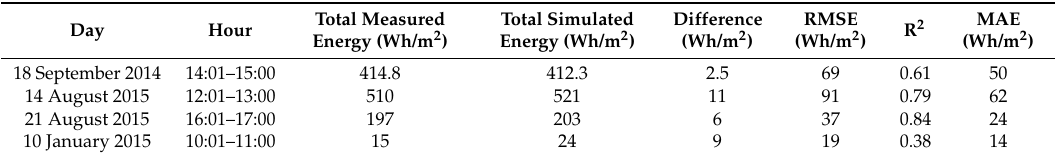
Table 4. Summary of the statistical indicators of the new ANN forecast model for four different